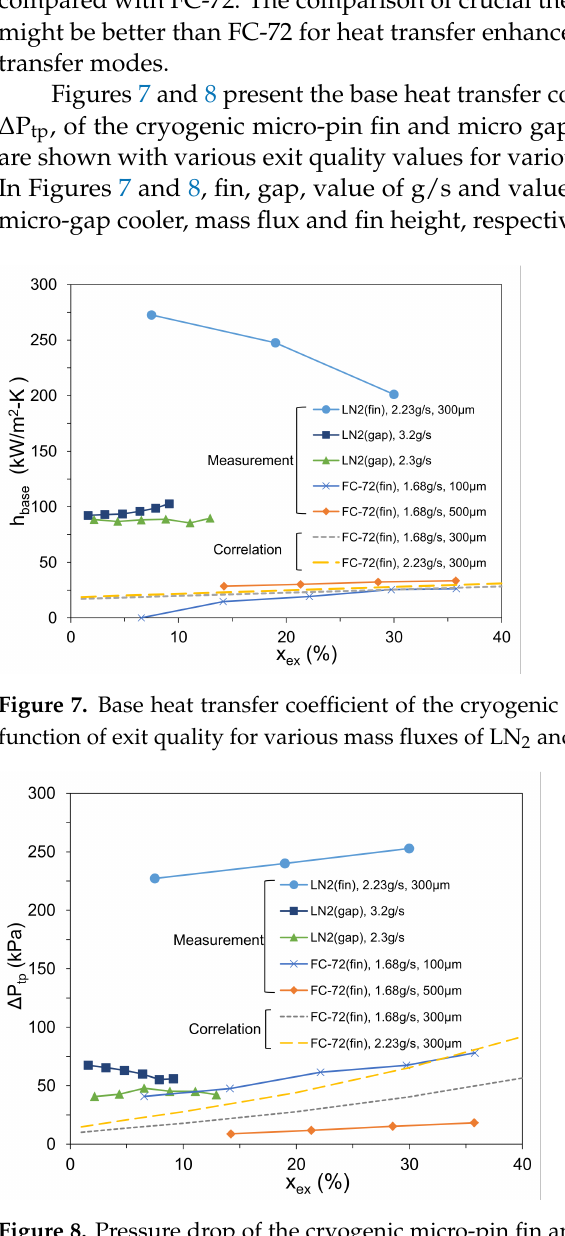
Figure 8. Pressure drop of the cryogenic micro-pin fin and micro-gap coolers as a function of exit quality for various mass fluxes of LN 2 and